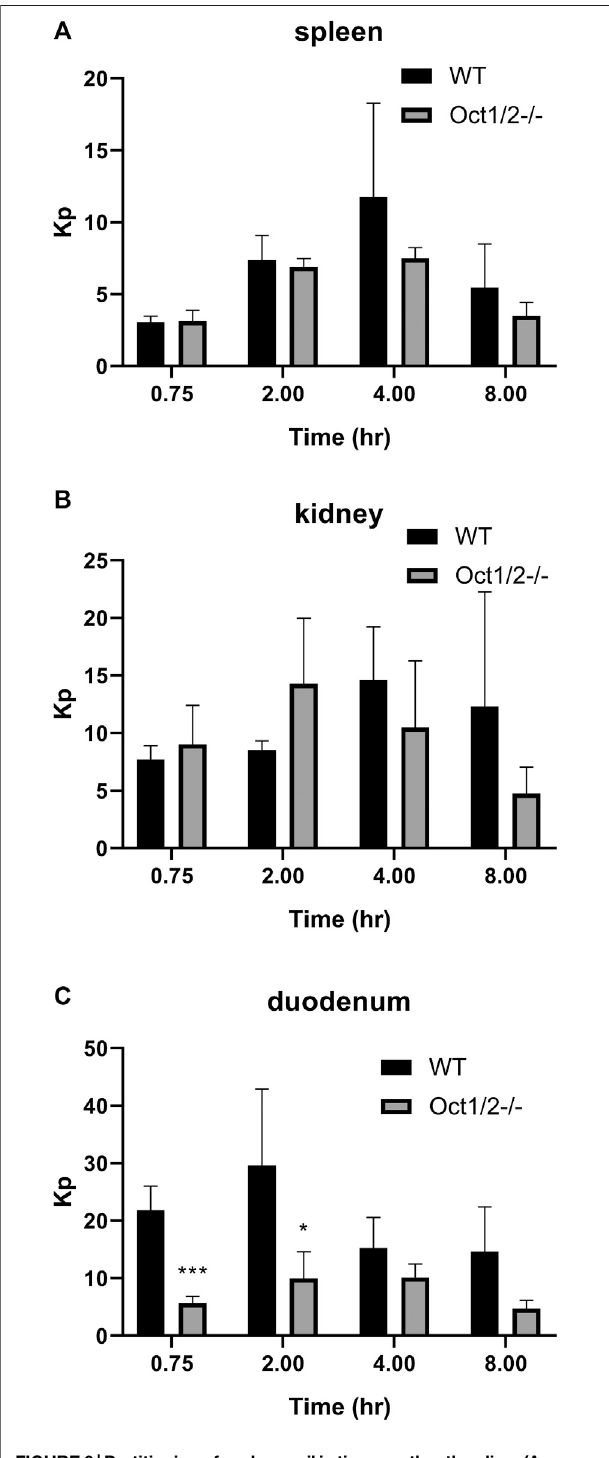
FIGURE6|Partitioningofcycloguanilintissuesotherthanliver(A and B, C) in wildtype (WT) and Oct1/2 − / − mice following IV administration of cycloguanil. Mice ( n (cid:2) 4 – 5/timepoint) were administered 2 mg/kg cycloguanil and sacri fi ced 0.75, 2, 4, or 8 h post-dose. Data presented as mean ± SD. * p < 0.05 using student ’ s t-test, compared to WT. *** p < 0.001 using student ’ s t-test, compared to WT. Kp (cid:2) tissue:plasma partition coef fi